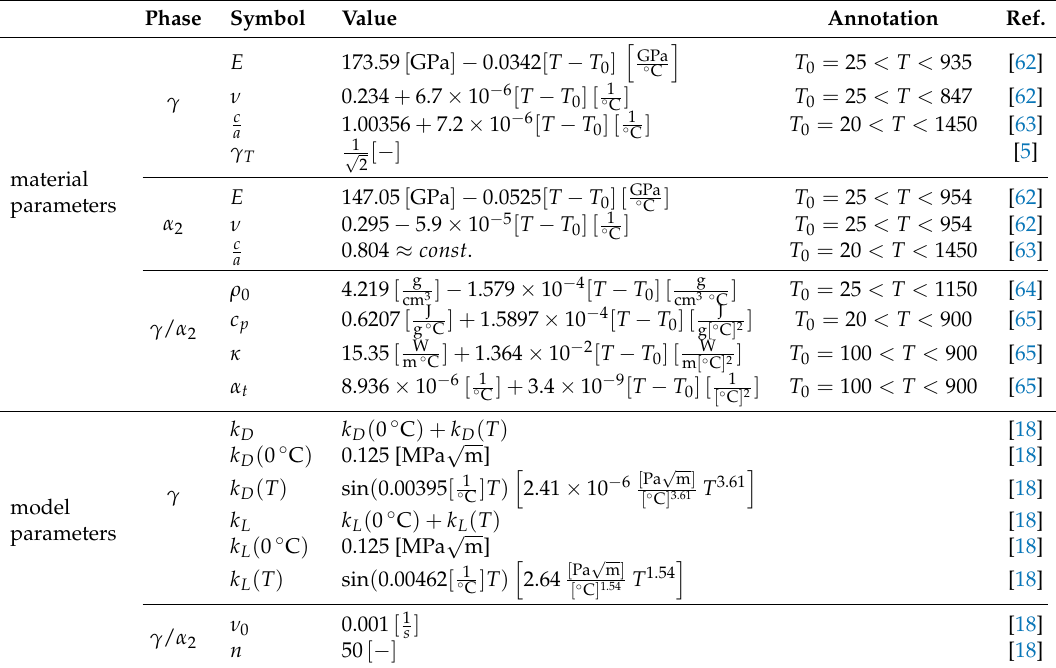
Table 2. Material and model parameters from